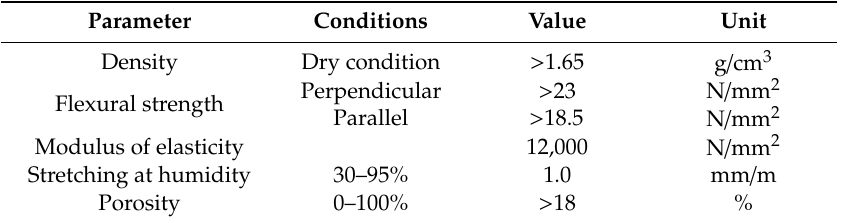
Table 3. Technical data of the tested